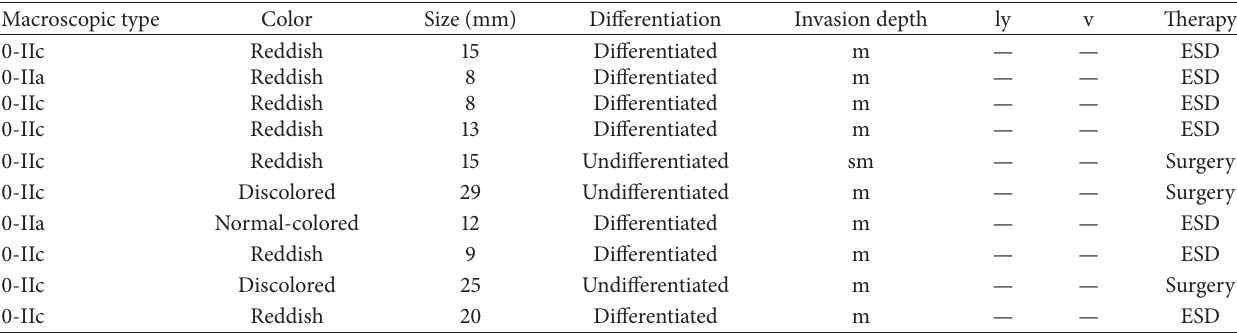
Figure 1: A still image of an early gastric cancer type 0-IIc in the lesser curvature of the gastric antrum. White light (a) and i-Scan (b) images were displayed in twin mode. Table 1: Clinicopathological features of the early gastric